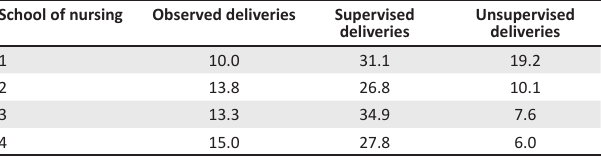
TABLE 3: Mean numbers of observed, supervised and unsupervised deliveries for respective schools of nursing. School of nursing